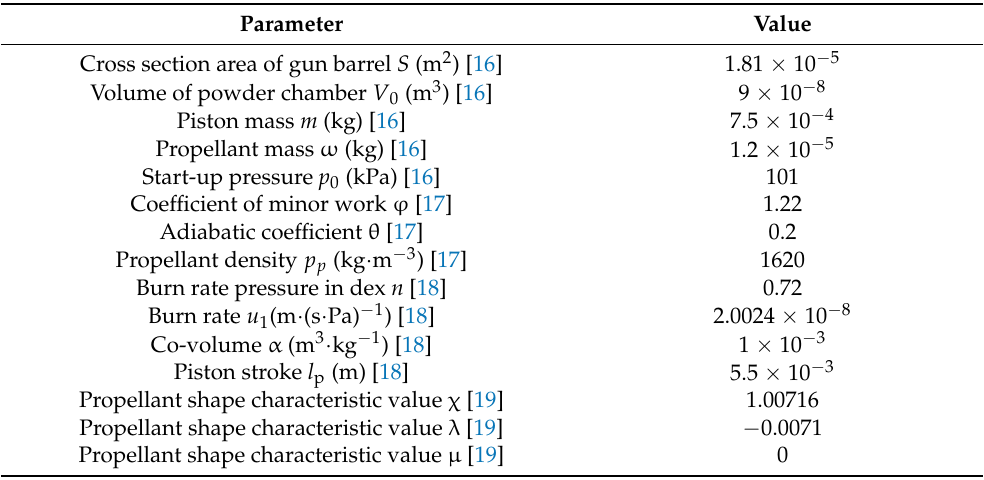
Table 1. Calculation parameters for in terior ballistic model